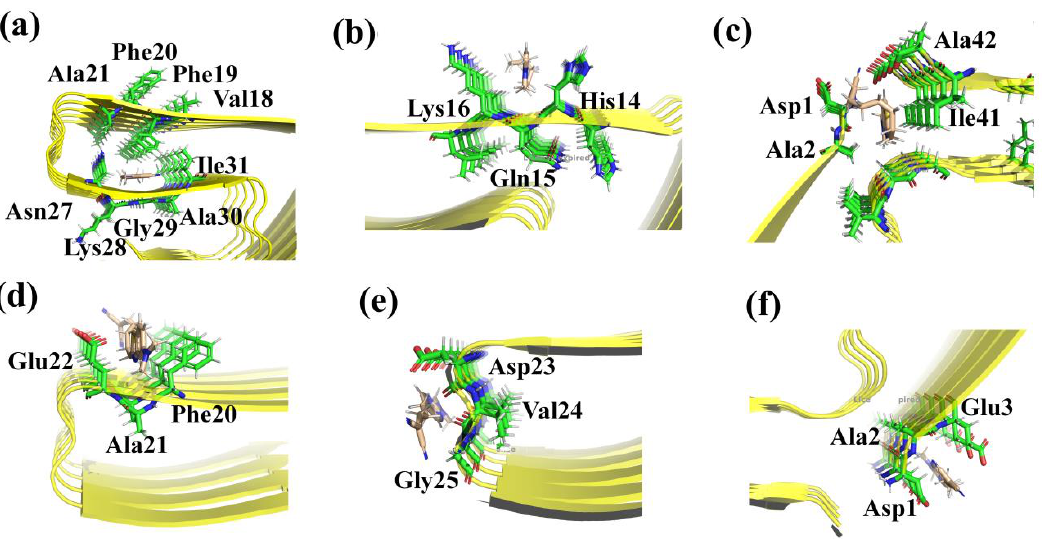
Figure 2. Detailed binding sites for a probe in β -amyloid ( a ) Site-1, ( b ) Site-2, ( c ) Site-3, ( d ) Site-4, ( e ) Site-5, and ( f ) Site-6. The fibril is shown in cartoon mode, and some important residues are shown in stick mode.